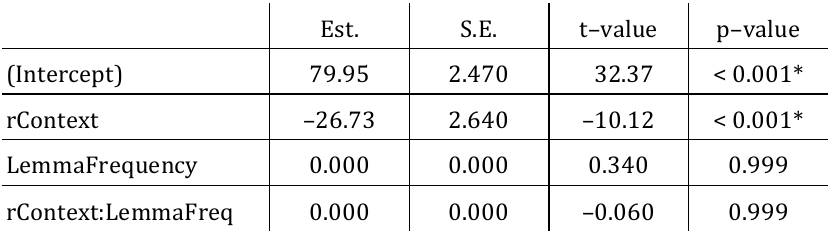
Table 5: Mixed-effects model for East Low